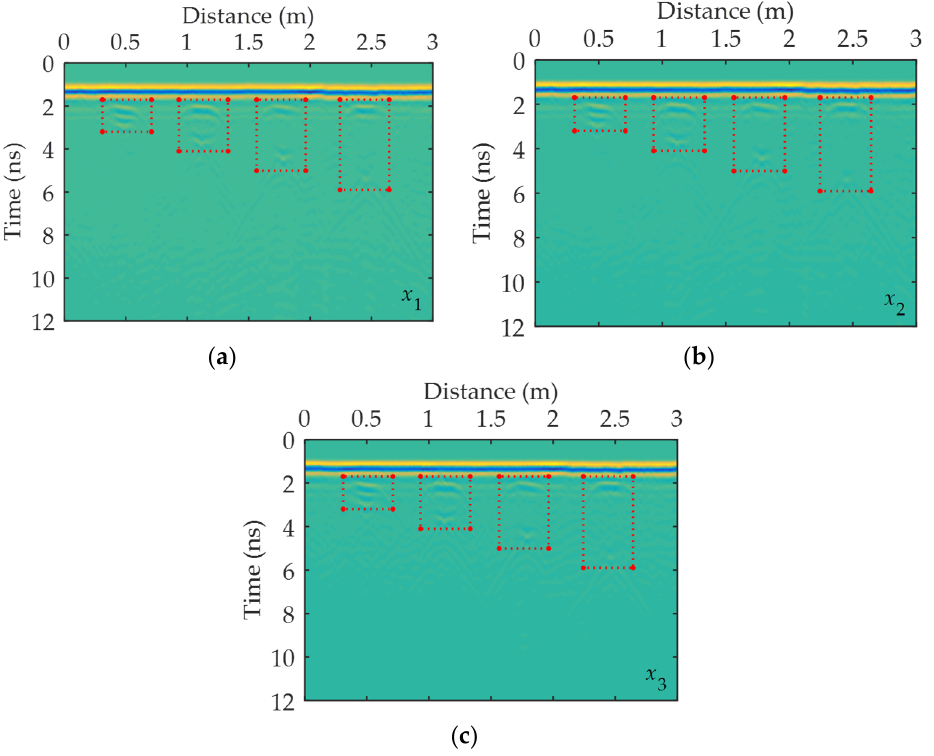
; ( b ) survey line x ; (c) 1 2